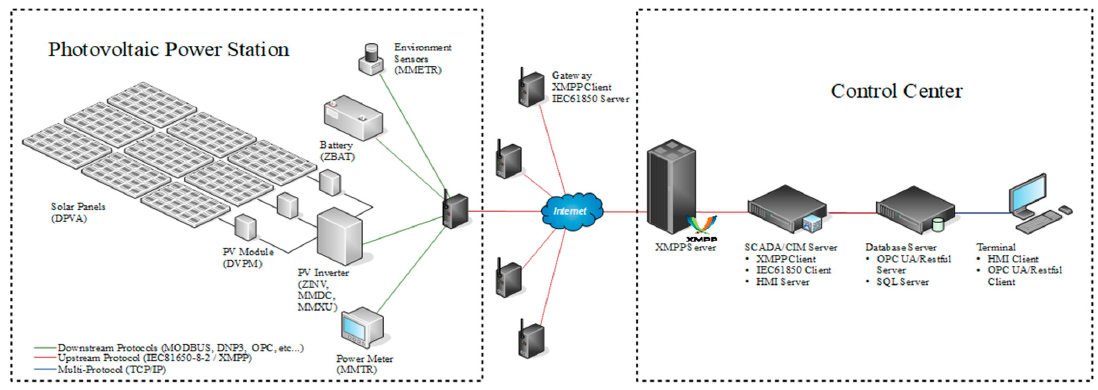
Figure 6. System Figure 6. System Architecture. Figure 6. System Architecture.